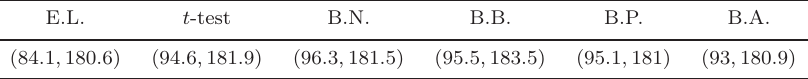
Table 2. 95% confidence interval for µ w − µ d calculated using the empirical likelihood method (E.L.); the two–sample t -test and four kinds of bootstrap (B.N. – normal